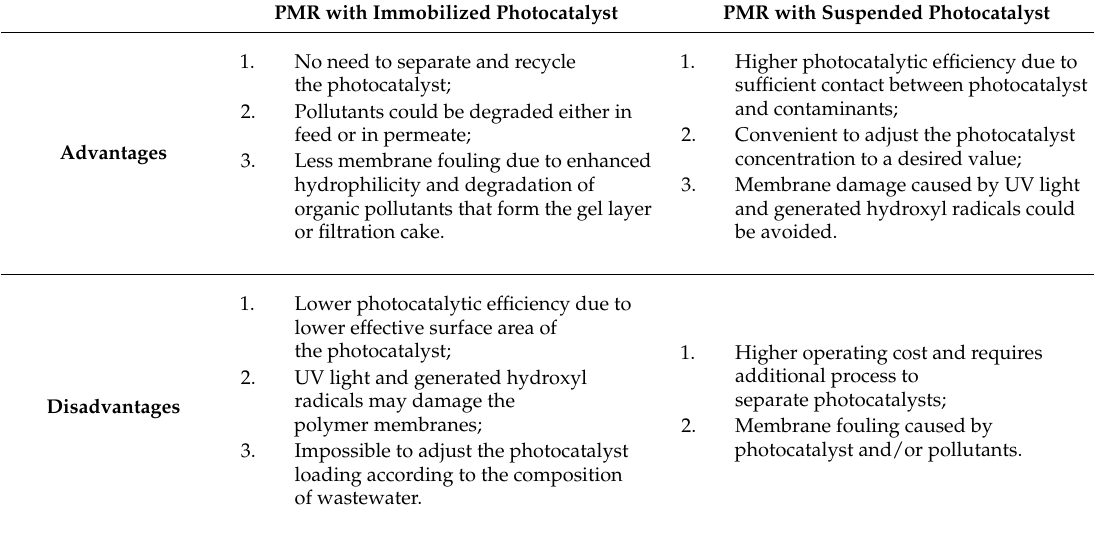
Figure 11. Schematic diagram of a lab-scale integrative PMR with UV lamps outside the reactor. Adapted with permission from [77], Copyright Elsevier, 2014. Main advantages and disadvantages of PMRs with immobilized/suspended photocatalyst